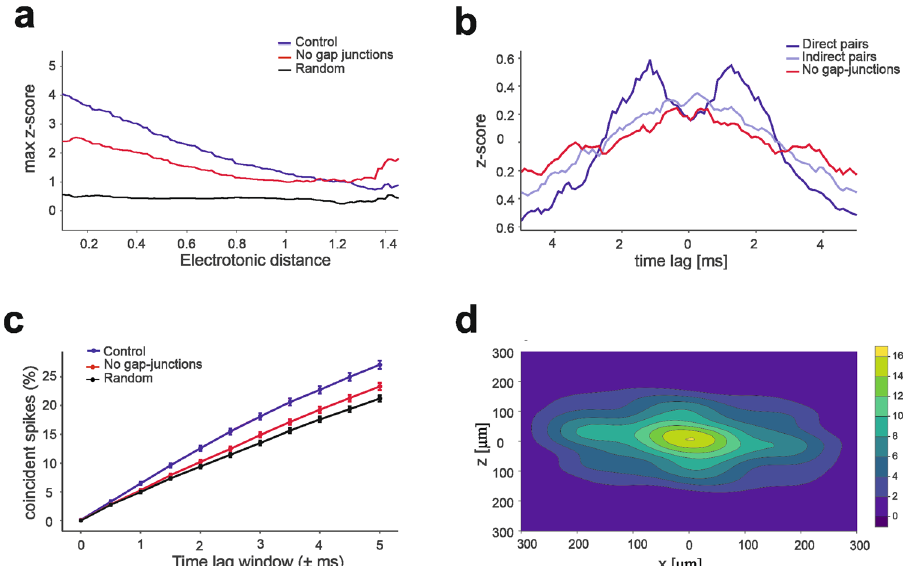
Fig. 4 GoC millisecond synchronization by gap junctions. a Maximum cross-correlation in pairs of Golgi cells as a function of electrotonic distance. The three curves represent control condition (4-Hz Poisson mossy fi bre activity), with gap-junctions disabled, and with random spike patterns of GoC s. All values were calculated using a sliding window of + − 0.2 electrotonic distance. At large electronic distances, the z-score in control conditions tends toward the value set by random input patterns. b The average cross-correlograms (0.5 ms bins) is calculated in control condition for GoC pairs at <100 μ m distance with either direct coupling ( n = 384), indirect coupling ( n = 842), all pairs located <100 µ m distance from each other when gap junctions were disabled when gap-junctions are disabled. The z-score shows two distinct peaks indicating GoC - GoC correlation with ms spike precision with on average 7.5 gap-junctions per direct pair. c The percentage of spikes that fall within distinct time-lag windows across all pairs located <100 µ m distance in control condition, with gap-junctions disabled, and with random spike patterns of GoC s. Points are mean ± SEM ( n = 1181). d Probability density of spike coincidence in the granular layer horizontal plane. This plot indicates that, with a GoC spike in [0,0], there is a certain probability that GoC s around it will fi re a spike within a ± 5 ms time-window. The integral of the probability density function over the whole network corresponds to the average spike coincidence for the same time window in ( c